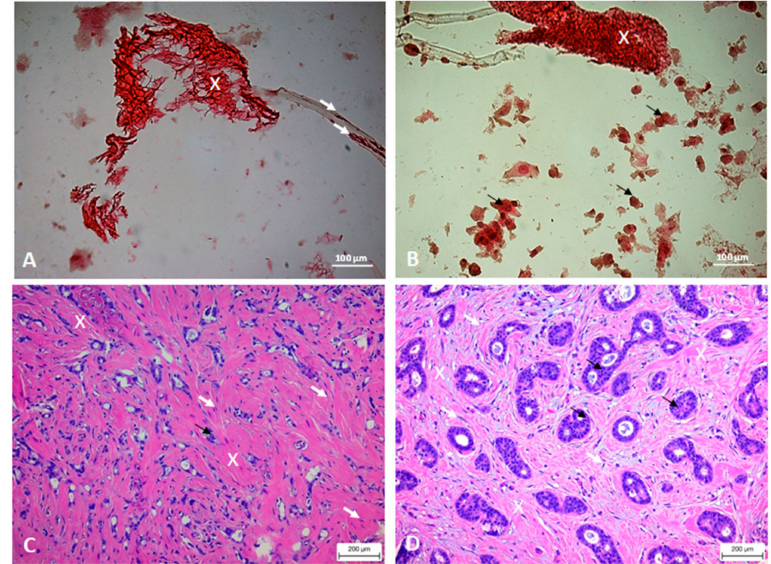
Figure 14. ( A , B ) Histological images acquired using inverted microscopy of the cells MDA-MB231 cultured in the 3D sca ff old for 7 days (20 × magnification) and stained with H&E. ( C , D ) histological images of an infiltrating ductal carcinoma of the breast (two di ff erent cases). The white crosses indicate collagen stained by H&E method, white arrows the